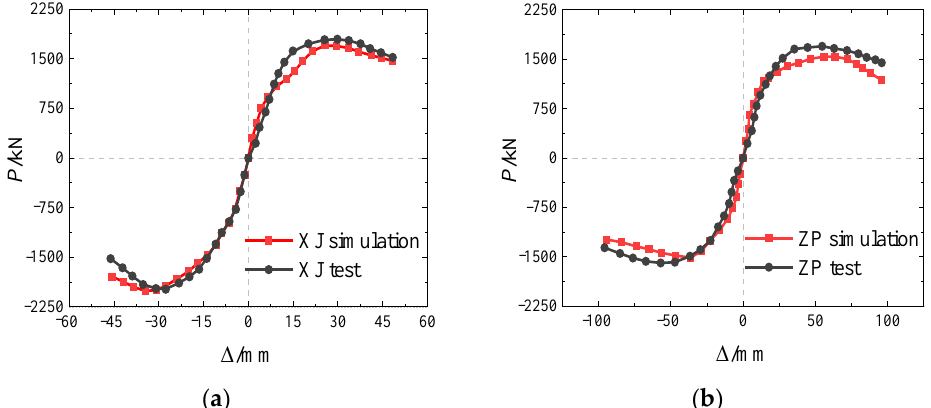
Figure 17. Physical test and simulated hysteresis curves for comparison. ( a ) XJ; ( b ) ZP.